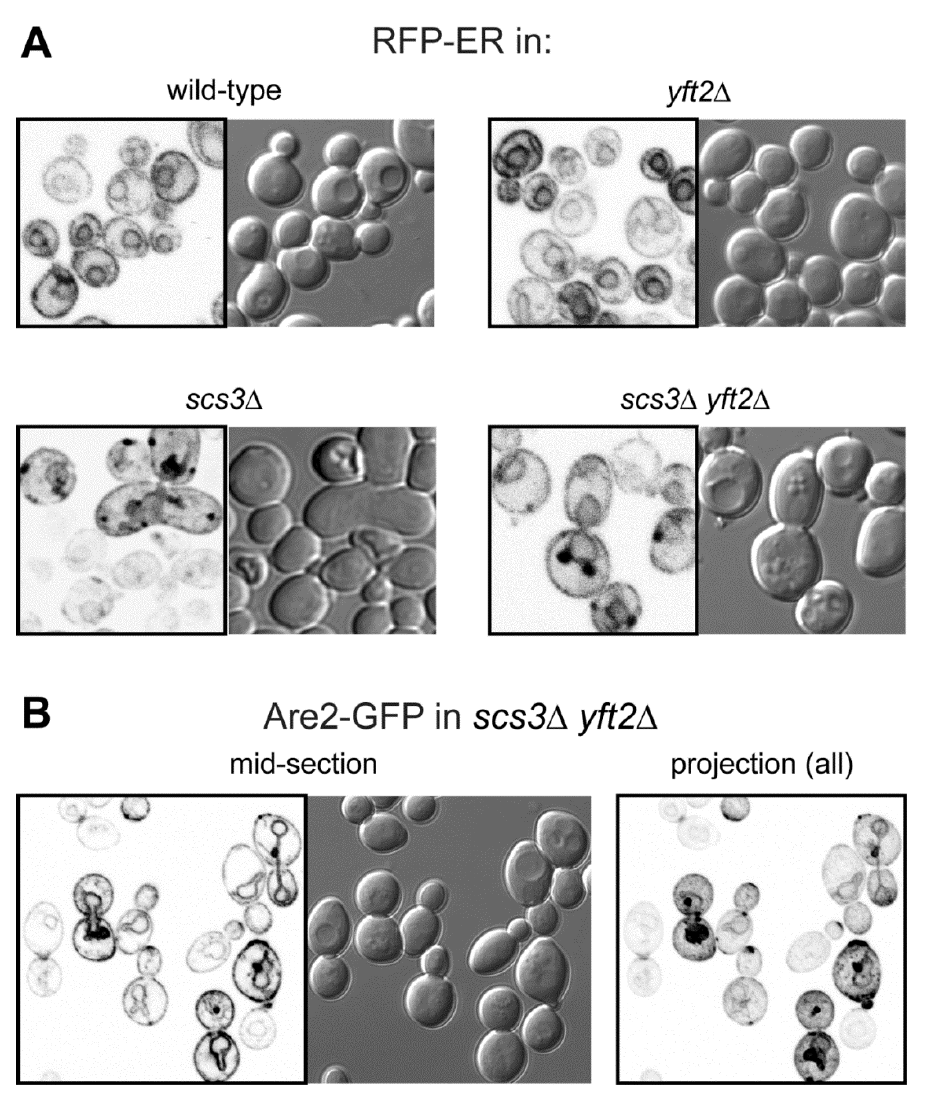
FIGURE 2: Punctate accumulations of ER form in cells lacking SCS3. Fluorescent (inverted gray scale) and DIC images of cells with indi- cated genotype expressing